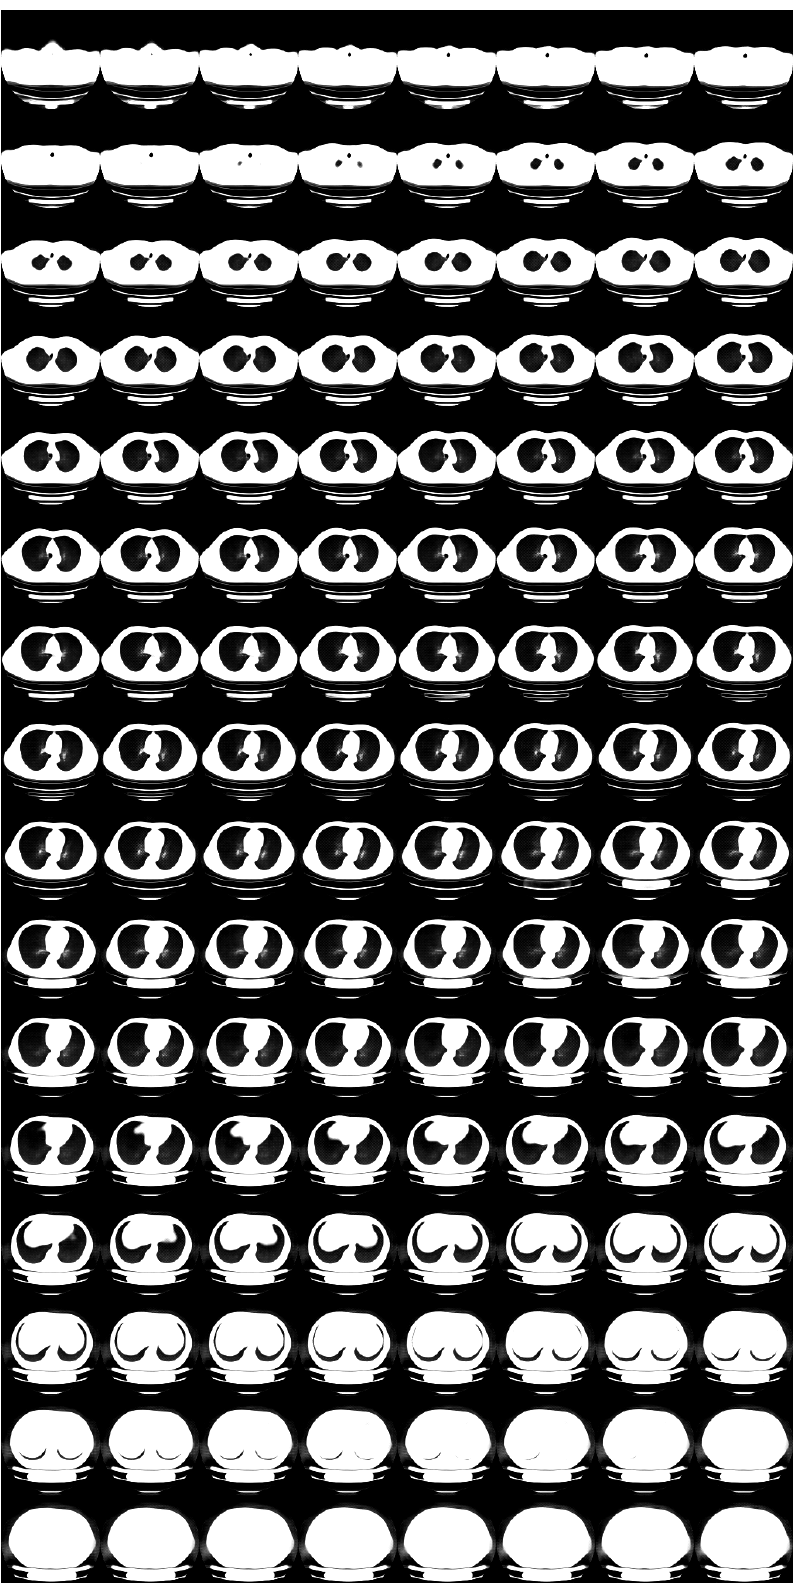
Figure A2. Fictional mean 3D CT image at the final epochs (sampled with T = 0, progressive learning), in pulmonary window